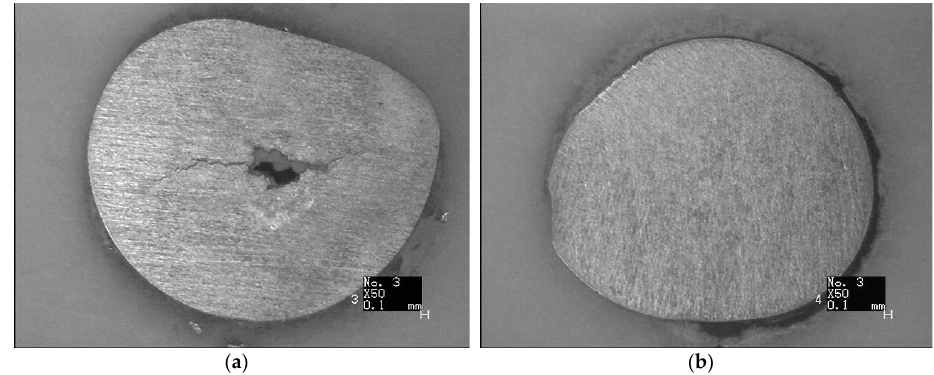
Figure 7. ( a ) Metallographic structure of axial through-wall crack; ( b ) Metallographic structure of #4 screw.